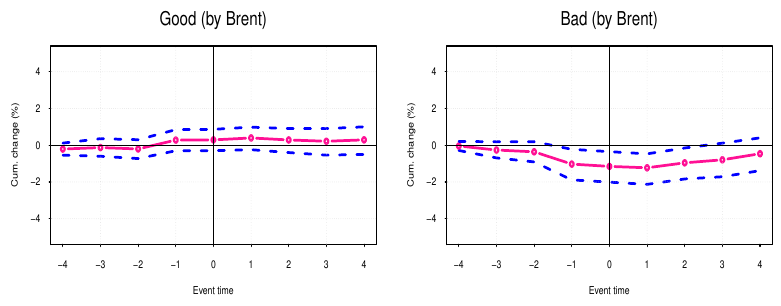
Figure 11. Extreme event on Brent oil and Renewable response.